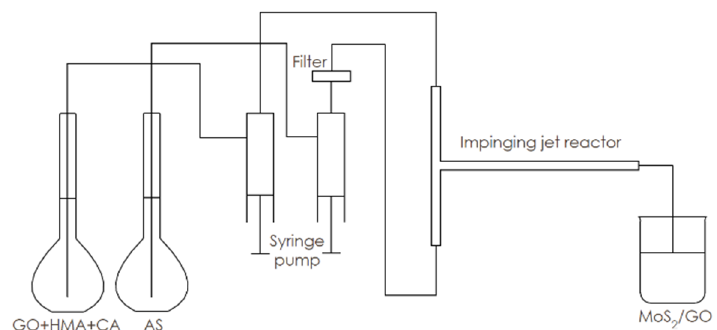
Figure 2. Synthesis of MoS 2 /GO in the impinging jet reactor.